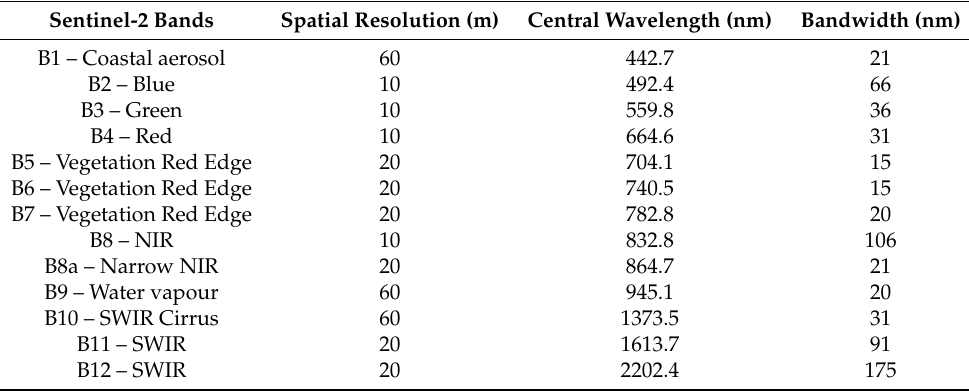
Table 1. Sentinel-2 MSI spatial resolution, central wavelength and